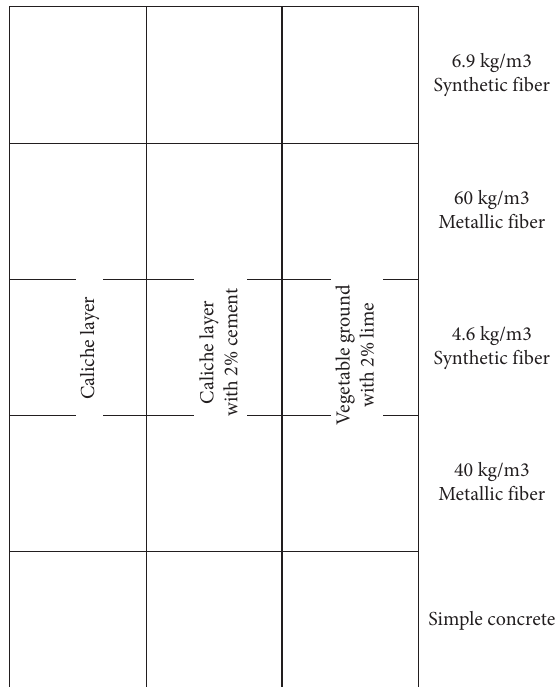
Figure 11: Distribution of concrete